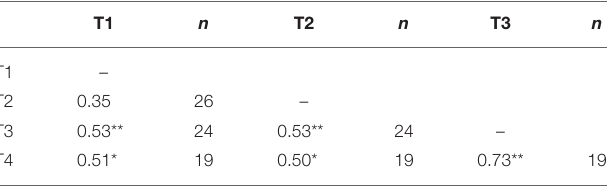
TABLE 4 | Correlations of procrastination scores over time: intervention group.